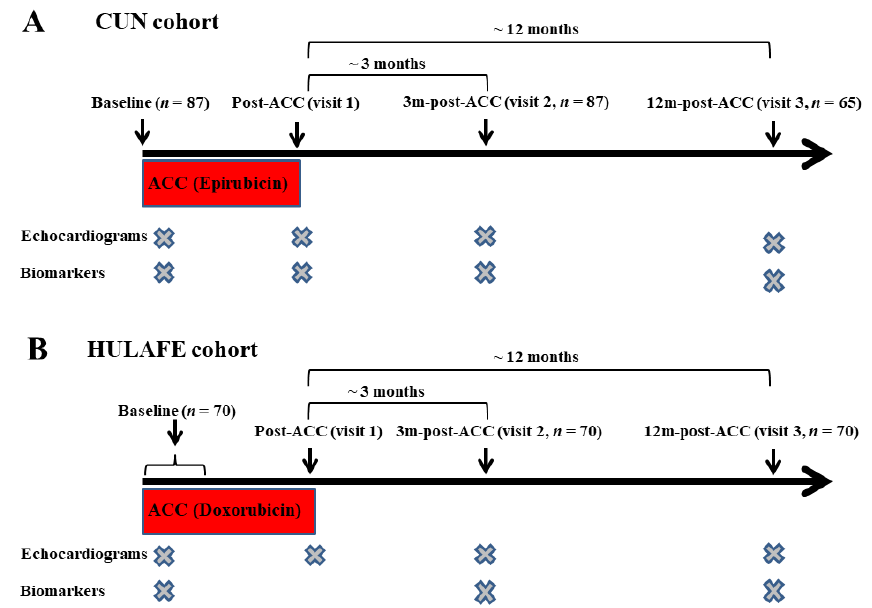
Figure 1. Study protocol in patients with breast cancer. The diagrams depict the study protocols in the CUN ( A ) and HULAFE ( B ) cohorts. Patients with breast cancer were studied before (baseline) and after ACC (post-ACC), and at 3 and 12 months post-ACC.